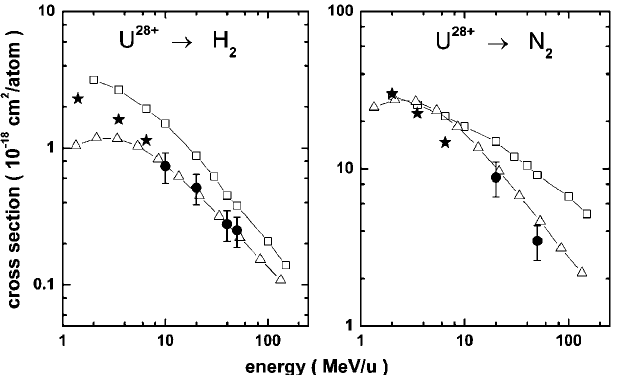
FIG. 2. Experimental cross sections per target atom in com- parison to calculations performed by Olson et al. (open squares) [13] and Shevelko et al. (open triangles) [24]. The experimental data points obtained in this work are denoted by full circles, while data from previous measurements by Franzke et al. [10] and Olson et al. [13] are denoted by full